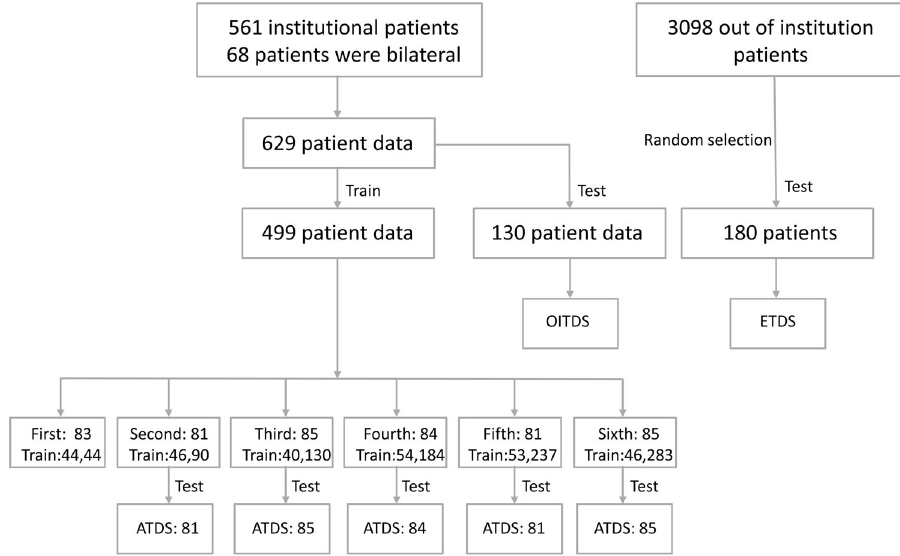
Fig. 1 Data construction fl owchart. OITDS organization internal test dataset; ETDS external test dataset; ATDS add test